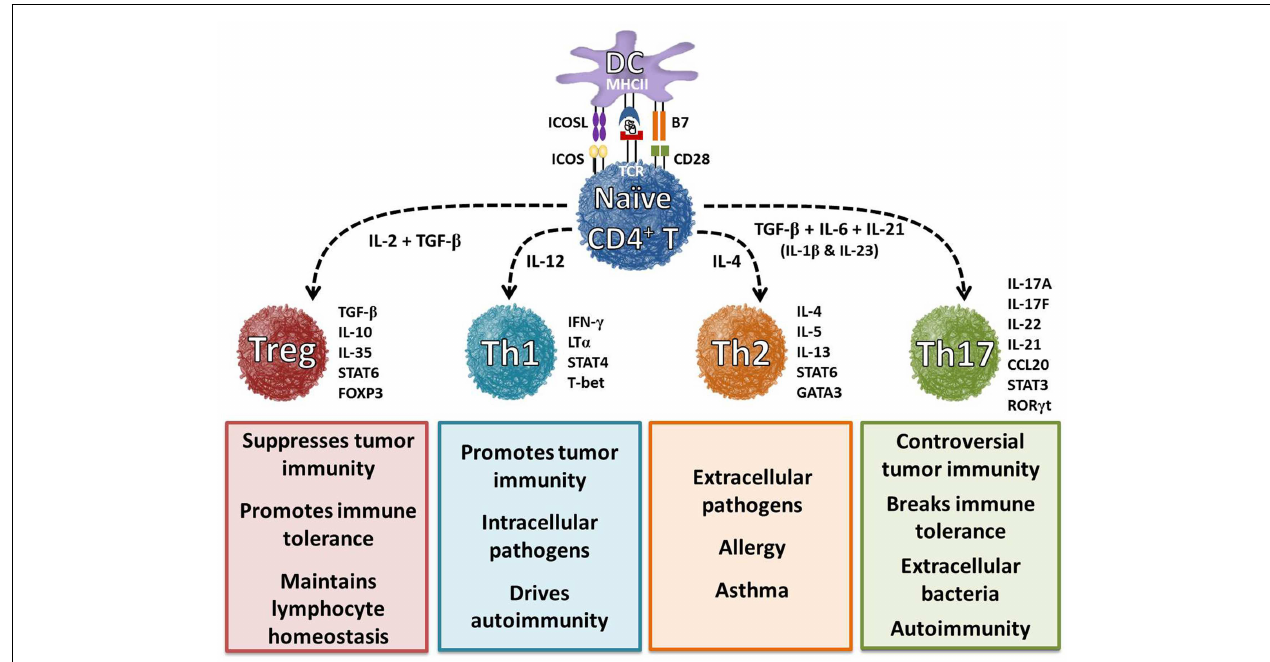
and stabilize this phenotype during cell expansion. Once programed, these cells secrete IL-17A, IL-17F, IL-21, and IL-22, which play a key role in enhancing autoimmunity and host defense. Cytokines IL-12, IL-4, andTGF- β and transcription factorsT-bet, GATA3, and FoxP3 have been shown to regulate Th1,Th2, andTreg cell development, respectively.These distinct subsets regulate immune response to foreign, self, and tumor